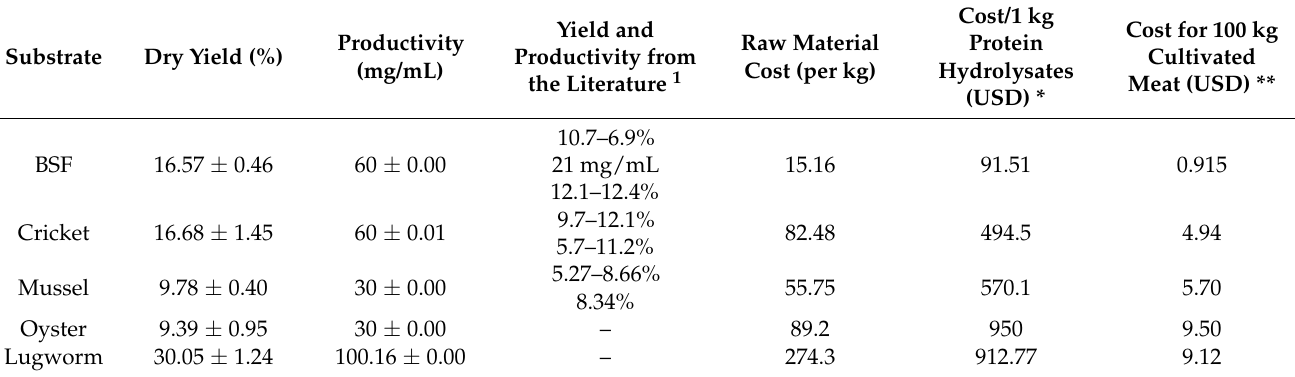
Table 3. Dry yield and productivity (mg/mL) obtained for all protein